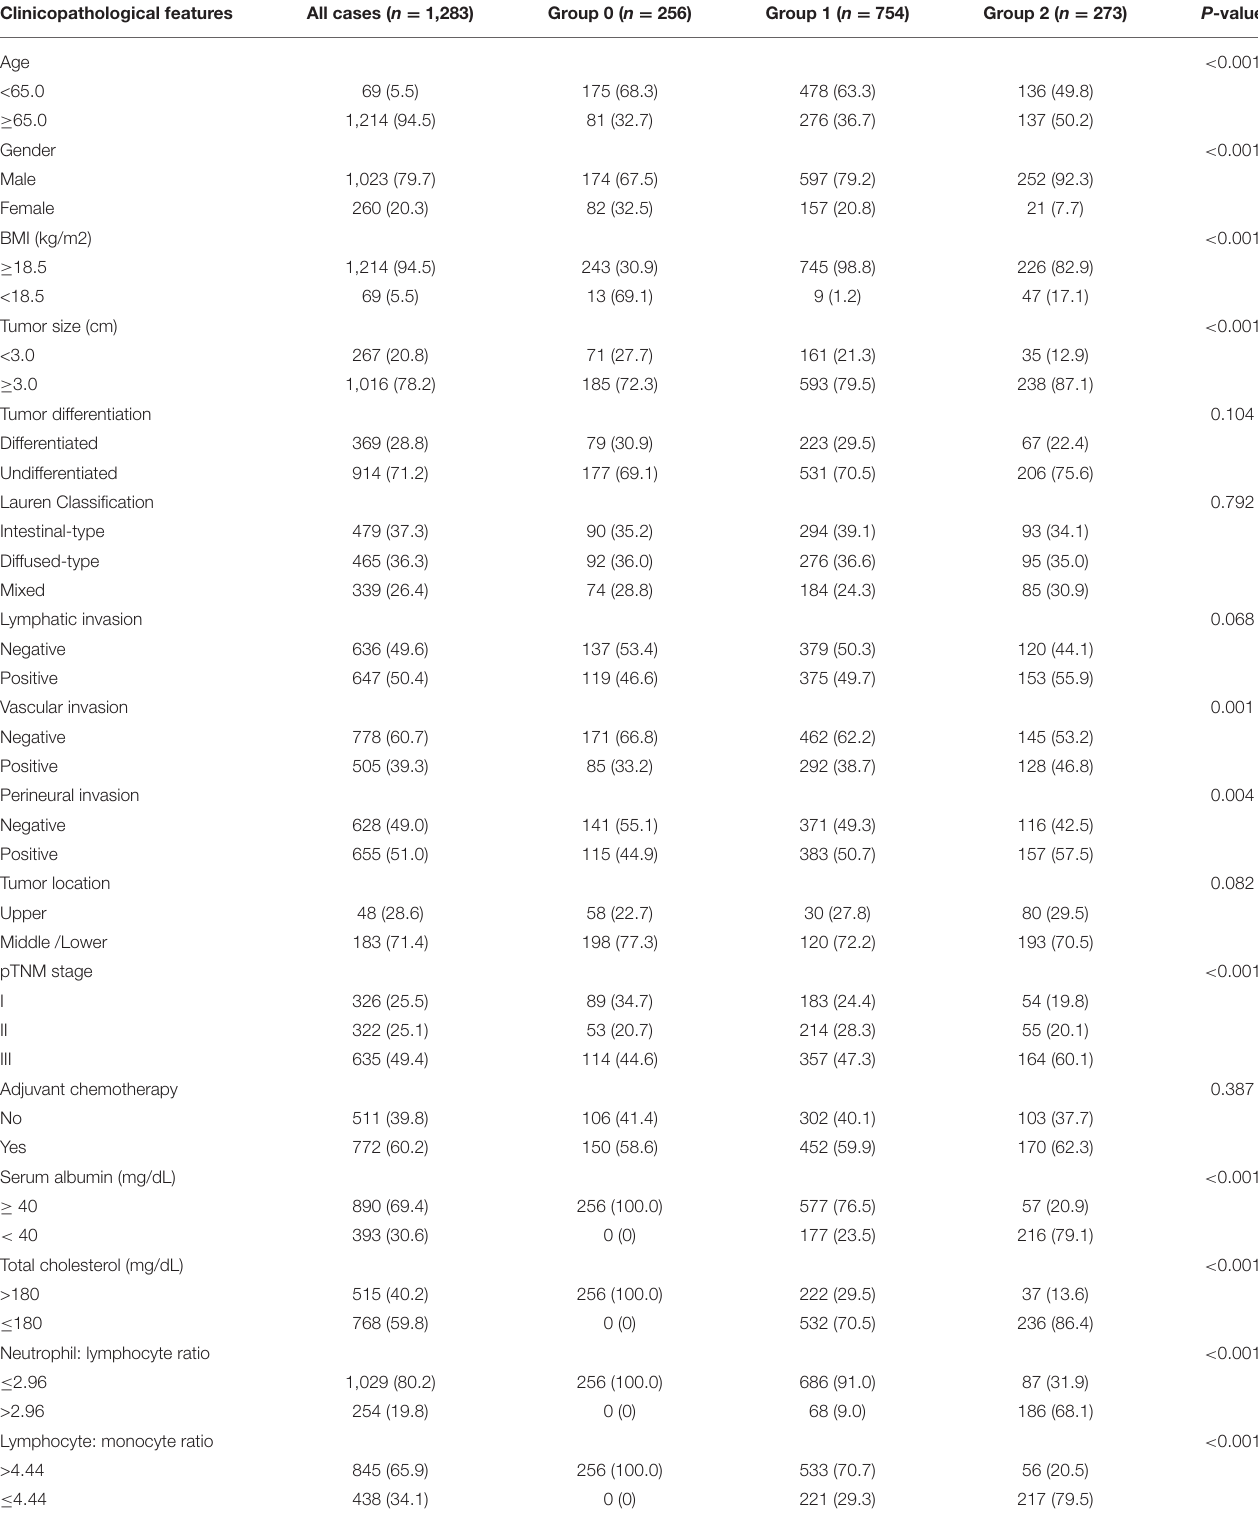
TABLE 1 | Association of NPS and clinicopathological characteristics in patients with GC. Clinicopathological